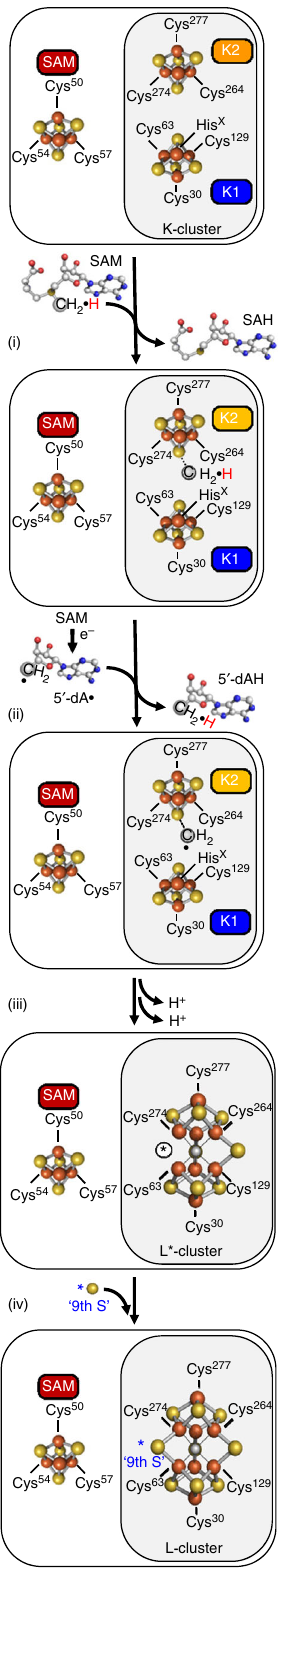
Fig. 4 Re fi ned model of L-cluster formation on NifB. This process begins with methyltransfer from one SAM molecule to a sul fi de of the K2 module via an S N 2-type mechanism (i), and it is followed by the formation of a 5 ′ - dA (cid:129) radical via homolytic cleavage of a second SAM molecule by the SAM- module, and the subsequent hydrogen abstraction from the K2-bound methyl group by 5 ′ -dA (cid:129) (ii). The resulting, K2-bound methylene ( – CH 2 (cid:129) ) radical then initiates the coupling/rearrangement of the K2- and K1- modules into an L*-cluster ([Fe 8 S 8 C]) that resembles the L-cluster ([Fe 8 S 9 C]) except for the absence of a belt sulfur (i.e., the 9th sulfur) (iii). Subsequently, the 9th sulfur is inserted concomitantly with further deprotonation/dehydrogenation of the carbon intermediate until an interstitial C 4 − ion is generated in the center of a fully assembled L-cluster (iv). These events are accompanied by loss of a conserved His ligand to the K1 module and, possibly, one or more Cys ligands to both the K1- and K2- modules, to accommodate the structural rearrangement of the cluster during this process (iii, iv). This model is proposed based on data from this work and a related work 28 . The encircled black asterisk in the scheme of L*- cluster represents the vacant site in the belt region of the cluster, which may be occupied by a cysteine thiolate or water